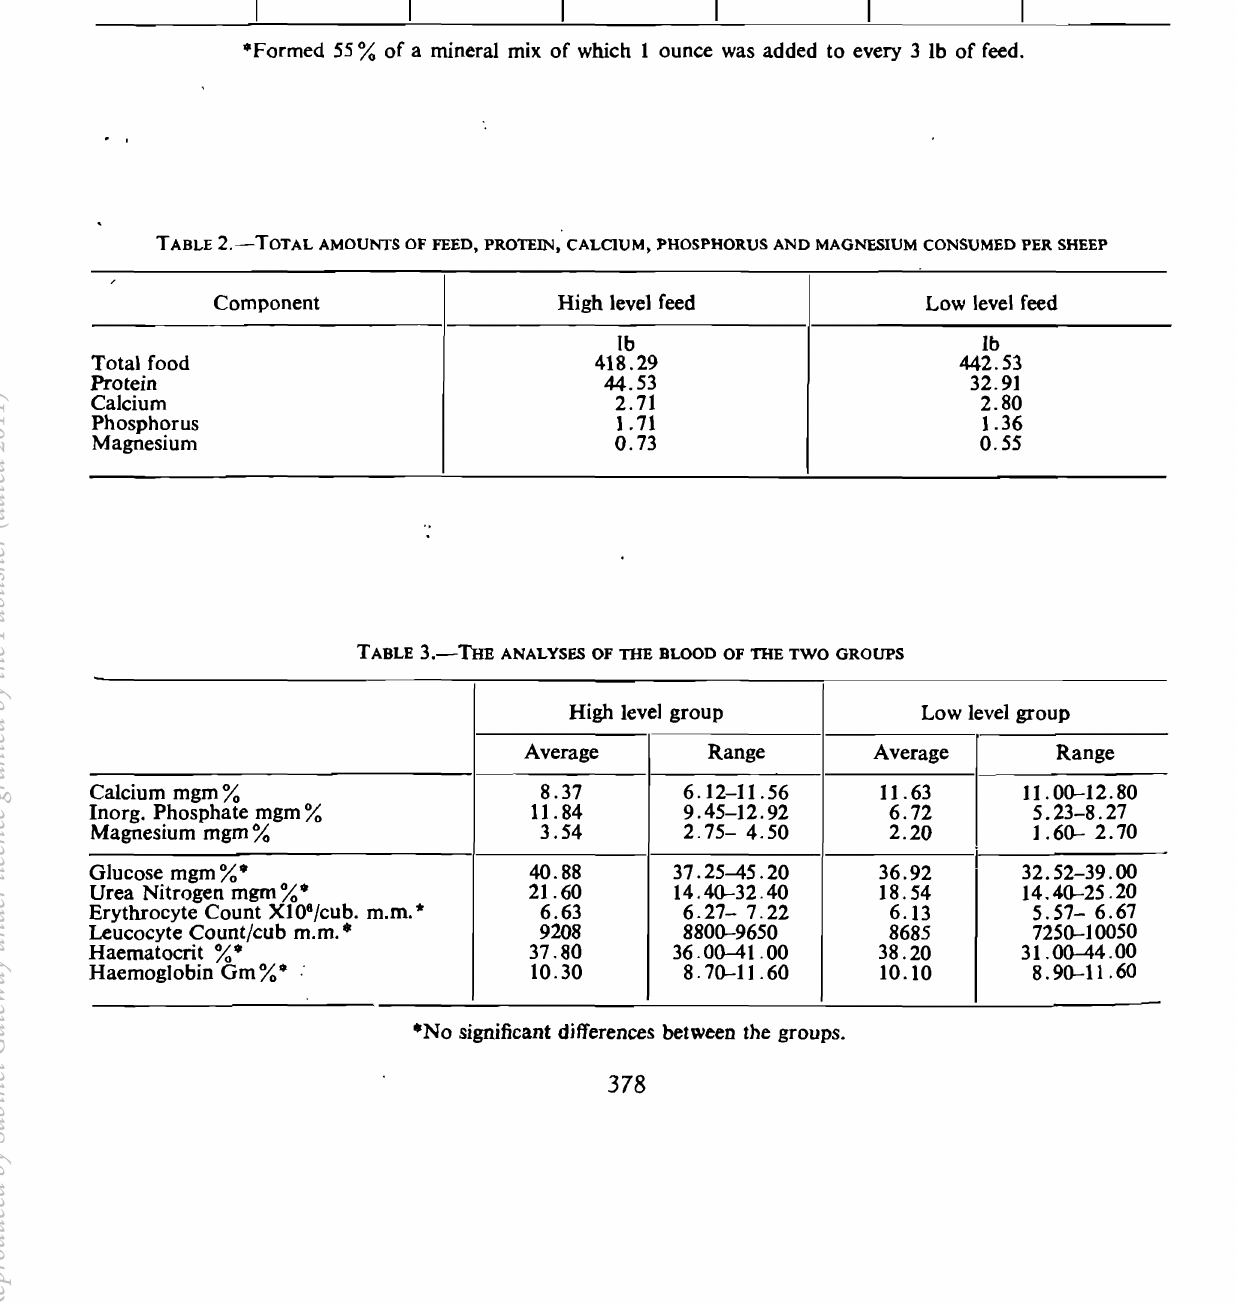
TABLE l.-COMPOSITION AND MINERAL ANALYSIS OF THE FEEDS Components